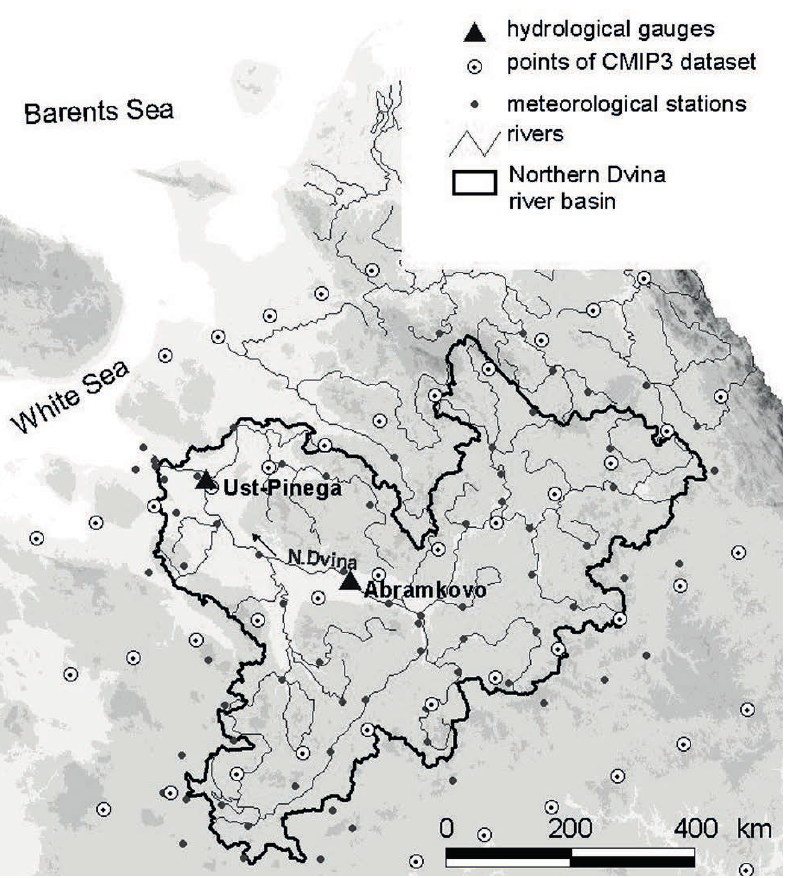
Fig. 1 The Northern Dvina River